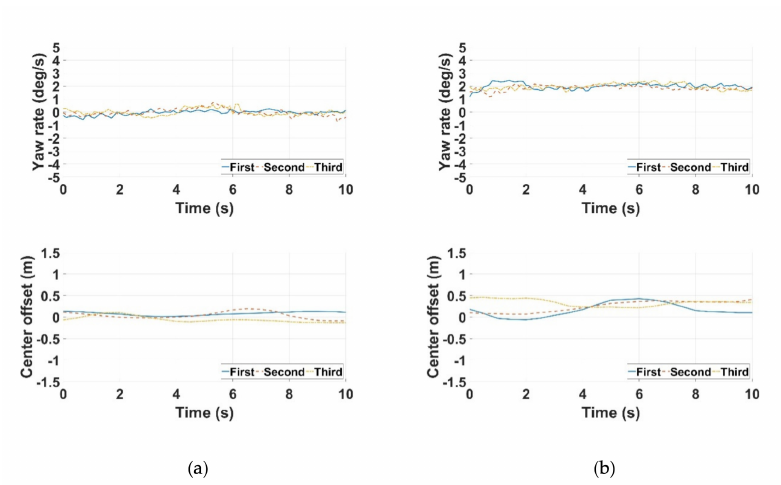
Figure 8. Yaw rate and distance to the center of the lane: ( a ) scenario 4 and ( b ) scenario 5.